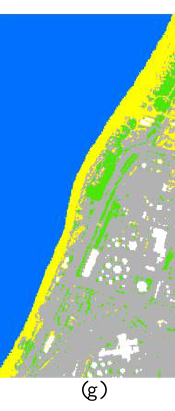
Figure 6. Post-processed sub-pixel mapping results. (a) The reference map. (b) HC. (c) ANN WT. (d) ANN WT CF. (e) SAM. (f) SAM CF. (g) PS.